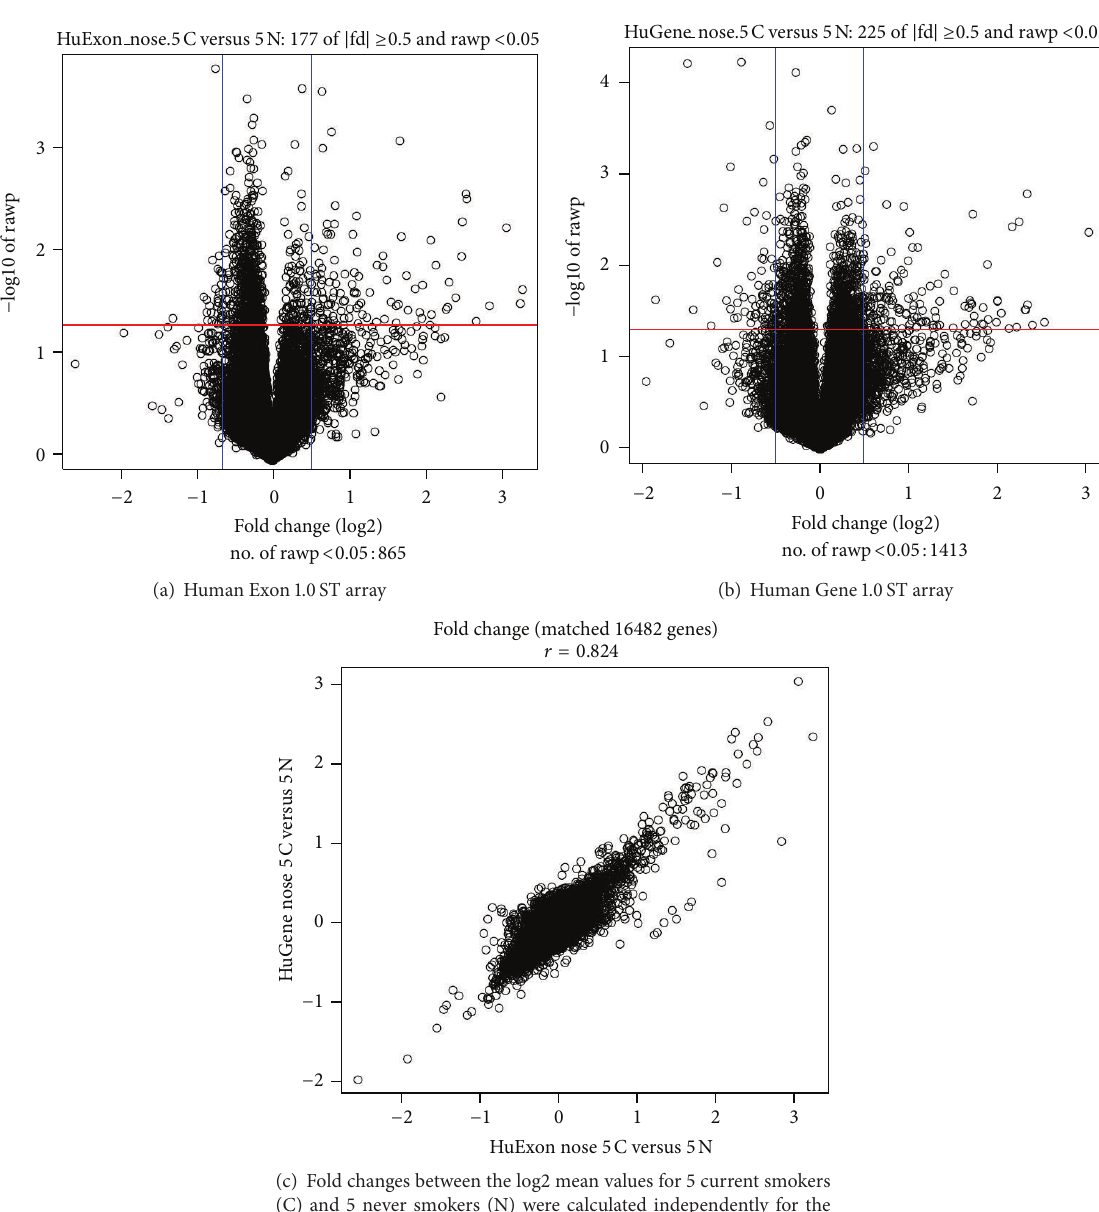
Figure 3: Smoking-induced differentially expressed genes using a Student’s t -test (a) within the Human Exon 1.0ST array and (b) within the Human Gene 1.0ST. (c) Correlation between smoking-induced gene-expression differences (fold change) of the Exon and Gene ST arrays for 16,482 best matched gene-level probe